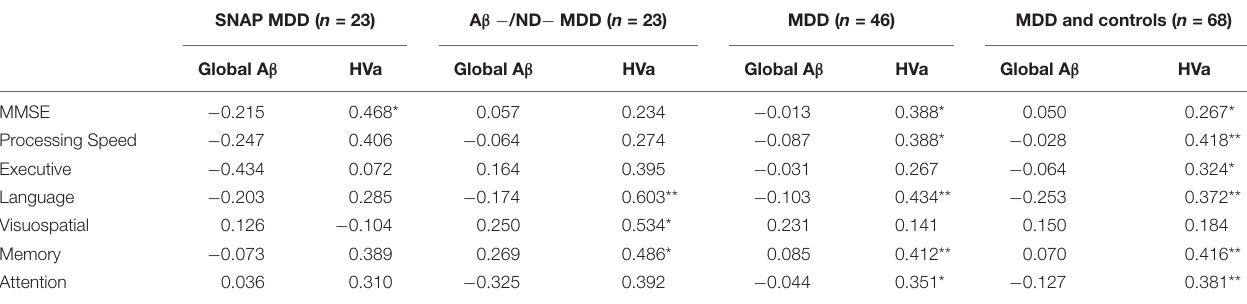
TABLE 3 | Correlations of cognitive functions with global cortical A β depositions and HVa in the different sample